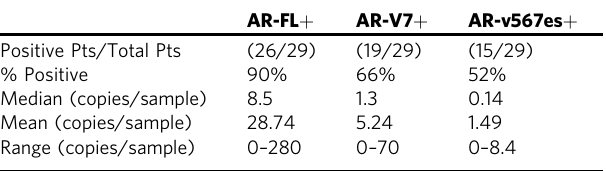
Table 1 showing the number of positive patients for each transcript, along with each respective median, mean, and range of expression values (copies/sample).